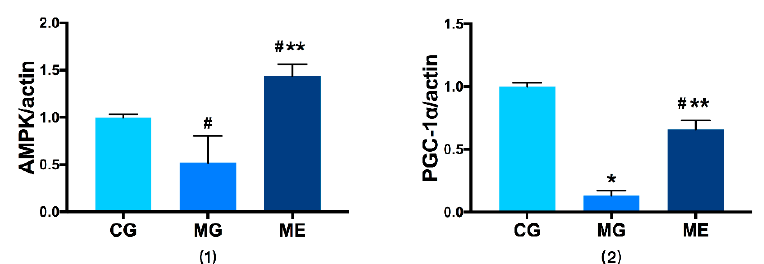
Figure 4. Gene: PGC-1 α , Internal reference gene: actin. (1) shows the results of AMPK / action, (2) shows the results of PGC-1 α / action. Control Group = CG, Model Group = MG, and Model Exercise Group = ME; * indicates p < 0.01 compared with CG; # indicates p < 0.05 compared with CG, ** indicates p < 0.01 compared with MG.